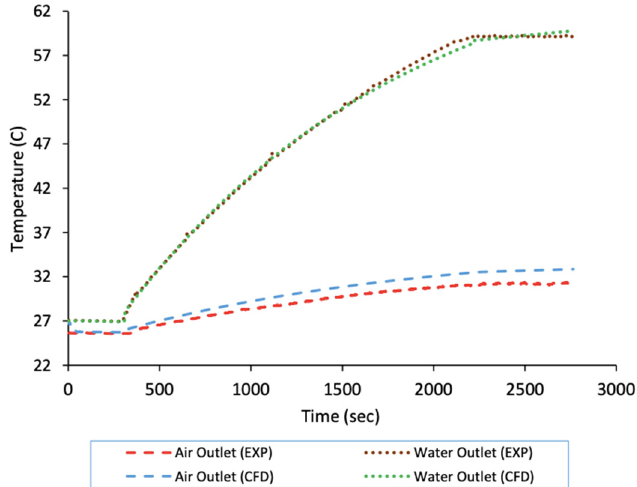
Figure 4. Starting up test showing experimental and transient CFD temperatures for air and water outlets. Table 1. Test matrix for the comparative steady-state tests conducted.